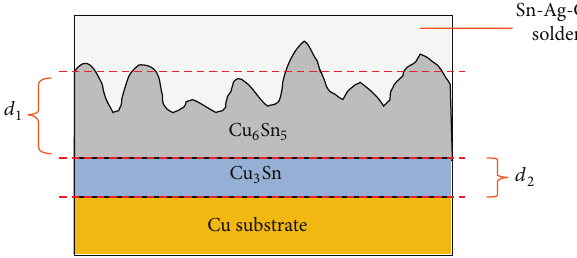
Figure 9: Schematic diagram of IMCs thickness measurements, with 𝑑 1 as the thickness of Cu 6 Sn 5 and 𝑑 2 as the thickness of Cu 3 Sn.